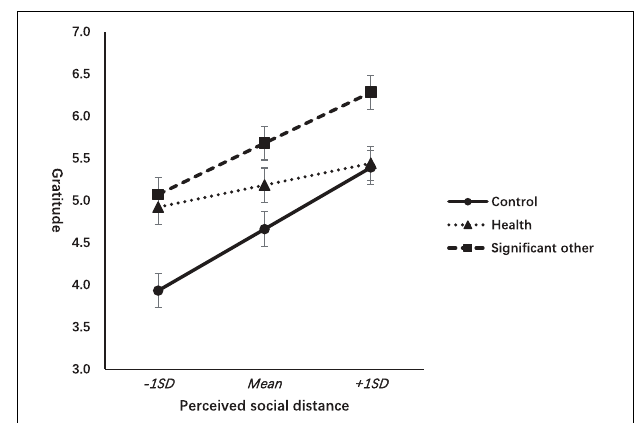
FIGURE 2 | Effects of gratitude interventions (significant other vs. control) on indebtedness across levels of perceived social distance. among participants with closer perceived social distance ( b = 1.53, t = 3.33, p = 0.001, 95% CI: 0.62, 2.44) but not significant